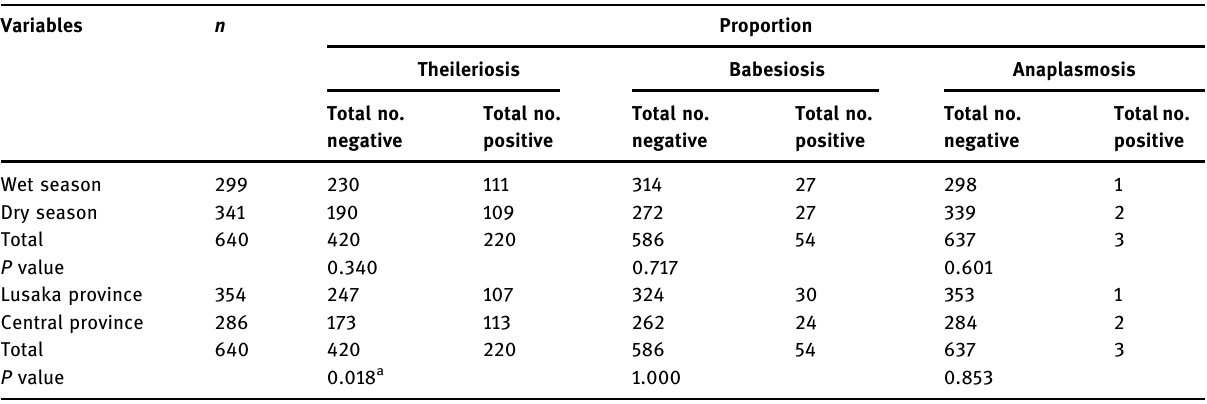
Table 2: Statistical and proportional ( % ) analysis of TBDs according to province and season Variables n Proportion